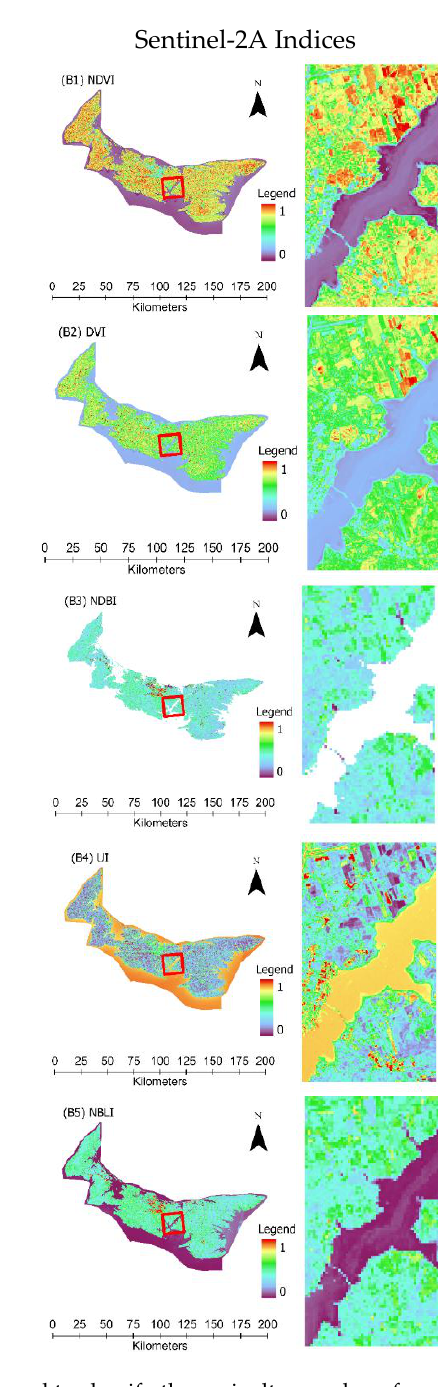
Figure 2. Sentinel-2A and Landsat-8 indices are used to classify the agriculture, urban, forest, and barren land cover. The right portion ( A1 – A5 ) and ( B1 – B5 ) of each figure shows the details of the selected portion. The minimum and maximum values of vegetation indices vary from 0 to 1.